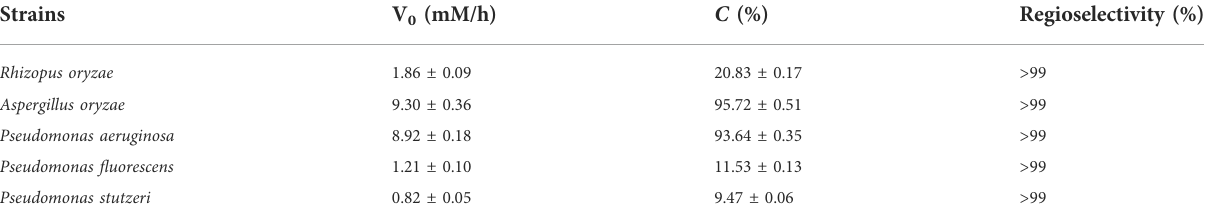
TABLE 2 Effect of organic solvents on caproylation of salidroside catalyzed by Aspergillus oryzae cells. Solvents Lop Acetone